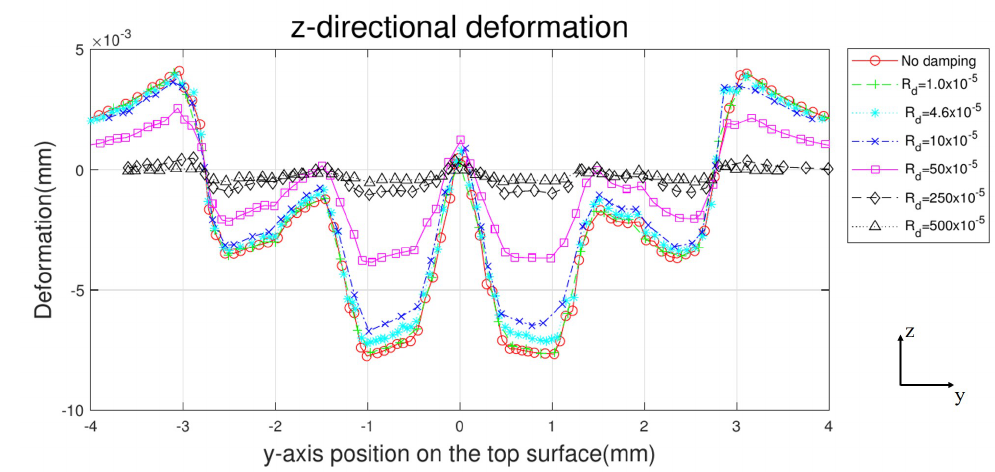
Figure 15. Z-directional deformation distribution on the top surface of multiple LSP FE